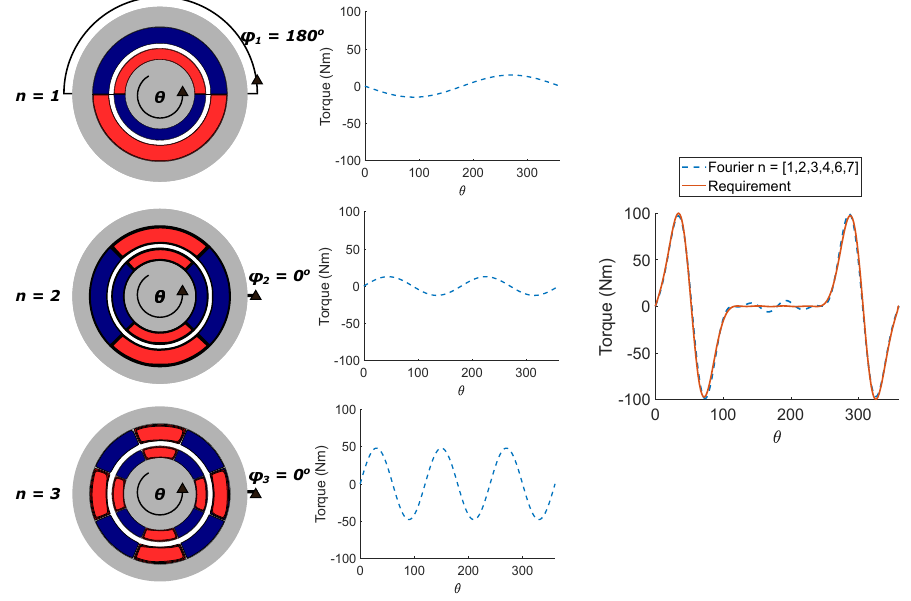
Figure 2. Decomposition based approach for multiple order magnetic